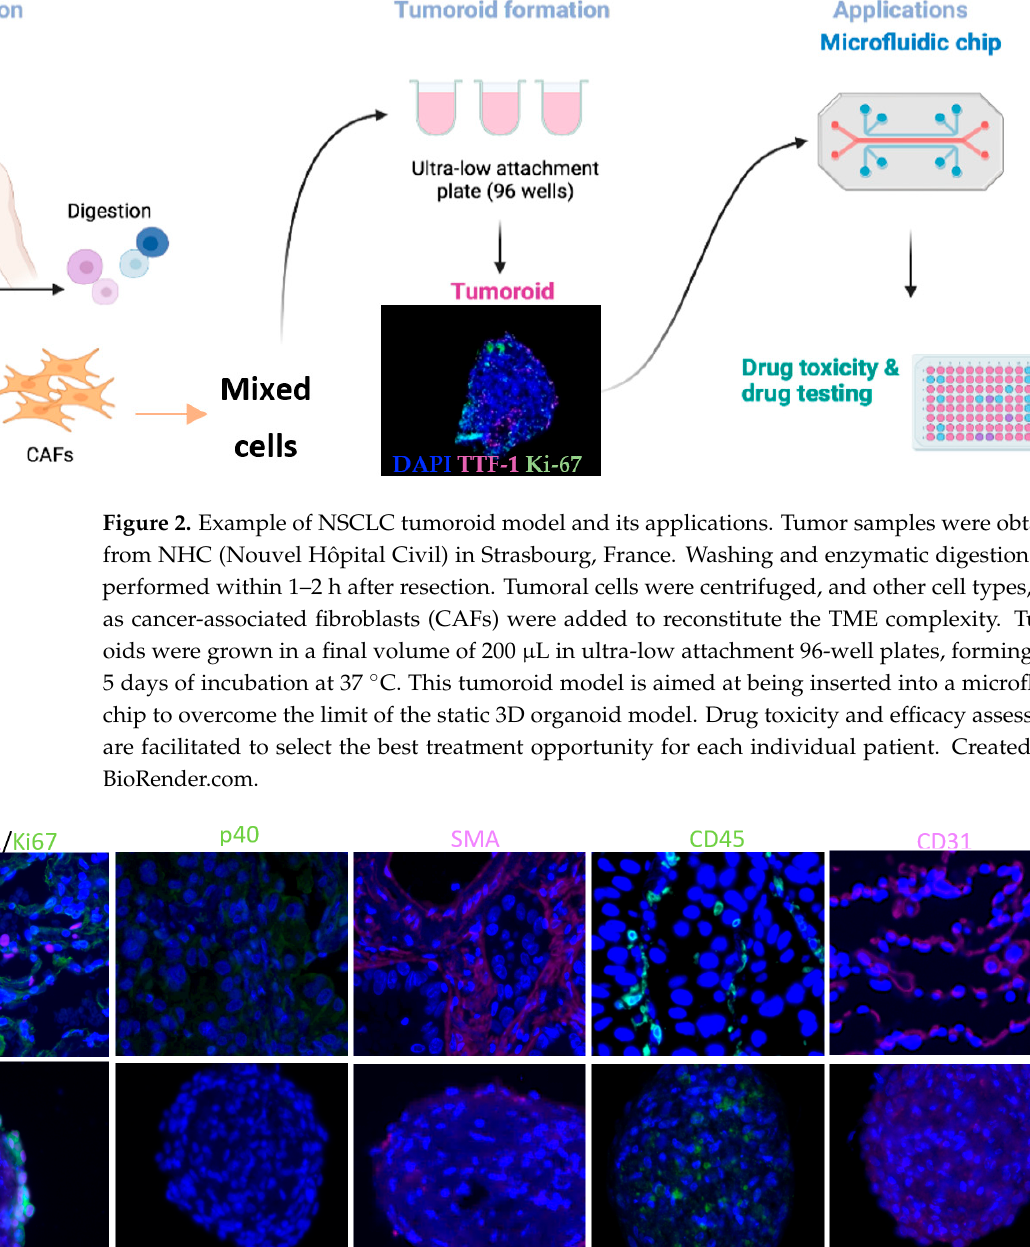
Figure 3. Immunohistochemical features of a patient-derived tumoroid and matched tissue. Patient 2OT 360 suffered from an advanced adenocarcinoma. Scale bar 100 μ m.